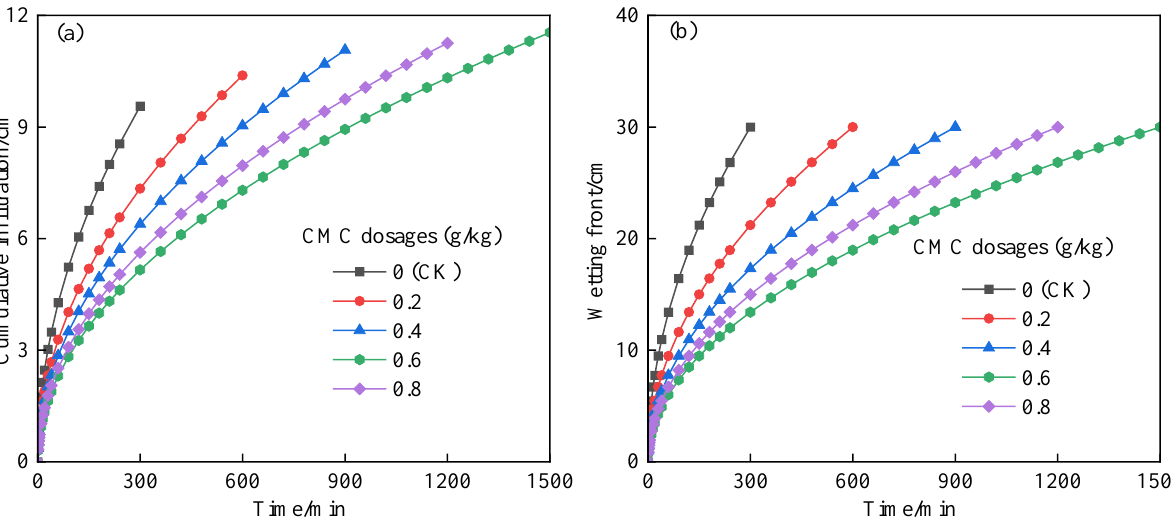
Figure 2. Effect of CMC dosages on soil infiltration characteristics. ( a ) Cumulative infiltration; ( b ) wetting front.